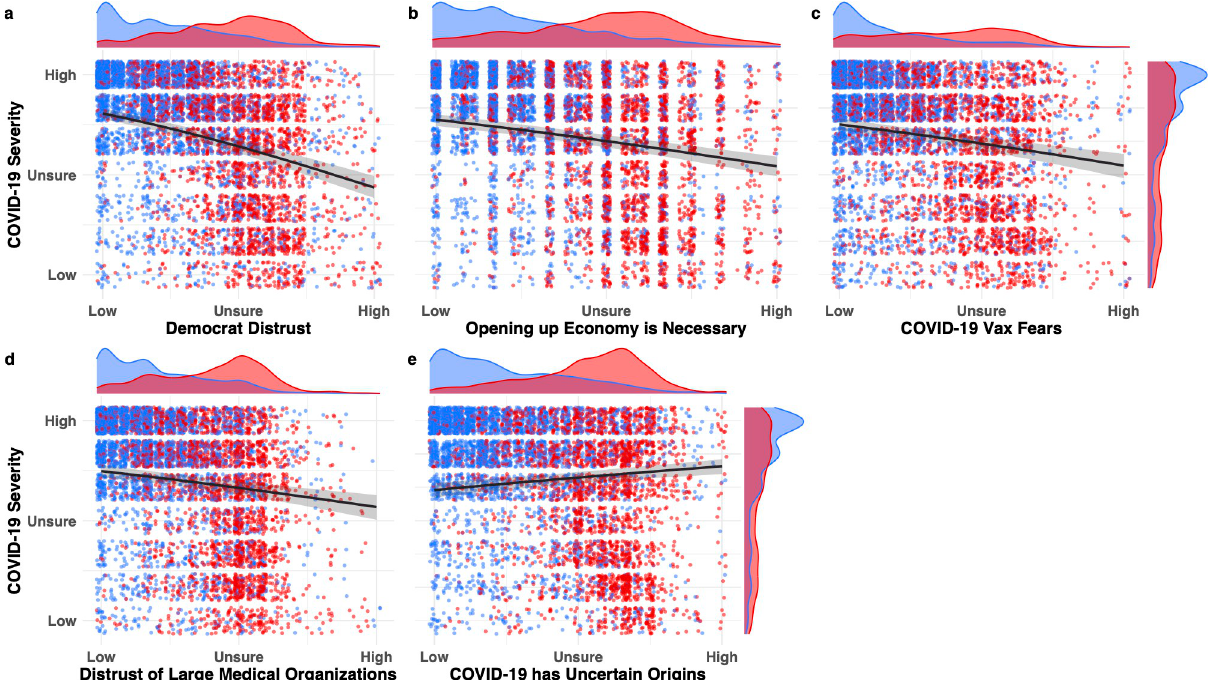
Fig 8. Histograms of five strongest predictors of first-wave COVID-19 skepticism and their relation to political ideology. Regression lines represent effect size estimates conditioned on the average response for the remaining predictors in the maximal model. Error regions represent 95% credible intervals (the interior 95% of the posterior distribution for the effect size). Participant-level averaged responses on the scales for those who identified as socially liberal (blue) and conservative (red) are jittered, with kernel density plots representing the distribution of responses for each predictor. Responses of participants who identified as moderate were excluded from visualization but were included in the model. Scale labels are recoded for readability from the original 7-point Likert scale (Strongly Disagree = Low, Neither Agree nor Disagree = Unsure), Strongly Agree = High). Horizontal density functions at top of each panel summarize distribution of responses by Democrats and Republicans on each predictor variable; vertical density functions at right summarize distribution of responses on the COVID-19 severity scale. participant’s averaged response on the scale colored by political stance. The five density plots running horizontally at the top of each of the five panels (a-e) show the degree of separation between how Democrats (blue) and Republicans (red) responded on the five measures, with Democrat responses being skewed to the right and Republican responses to the left. As was the case for the prewave survey (Fig 3), each of the predictor variables shows greater separation between Democrats and Republicans than did responses on the COVID-19 severity scale itself. (Note greater separation of horizontal blue and red density functions at top of each panel com- pared to the separation of vertical blue and red density functions at right of figure.) Thus, the tor variables than for beliefs directly about the severity of COVID-19.